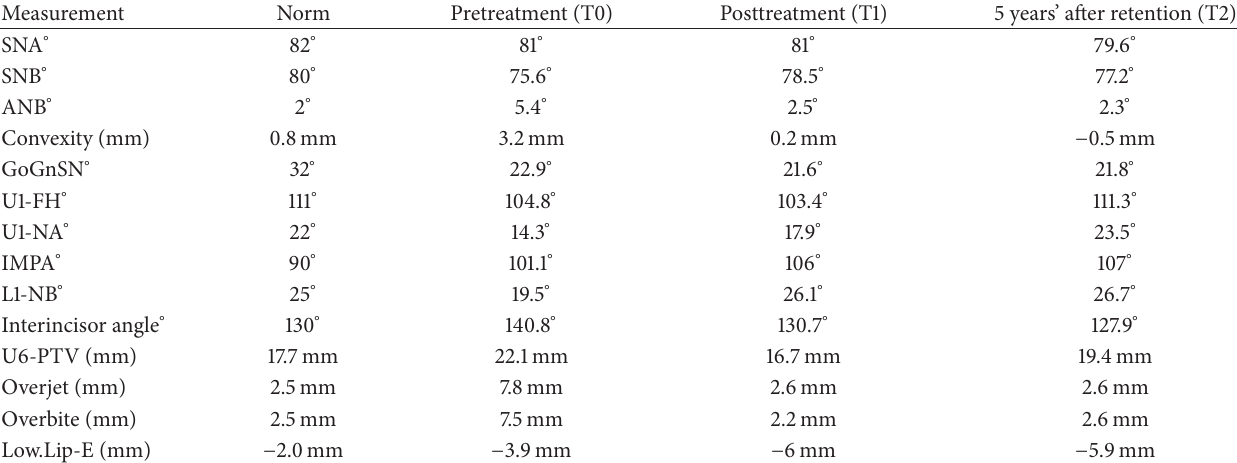
Table 1: Mean values of the measurements at pretreatment (T0), posttreatment (T1), and 5 years’ after retention (T2). Measurement